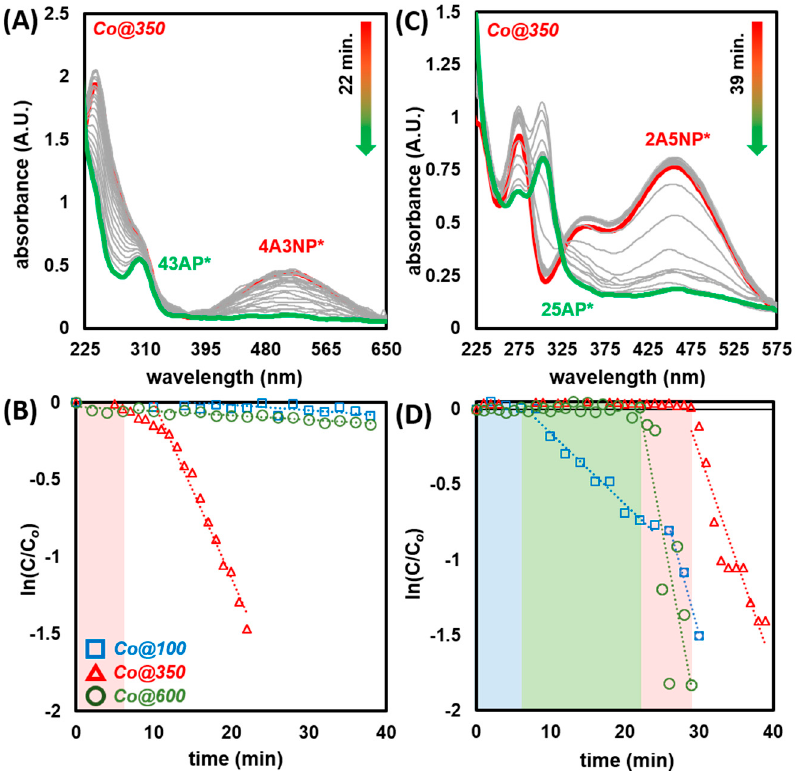
Figure 10. ( A ) UV-Vis spectra of the reduction of 4A3NP by Co@350 (SI for Co@100 and Co@600) and ( B ) plot of ln(C / Co) as a function of time for the reduction of 4A3NP by Co@100, Co@350, and Co@600. ( C ) UV-Vis spectra of the reduction of 2A5NP by Co@350 (SI for Co@100 and Co@600) and ( D ) plot of ln(C / Co) as a function of time for the reduction of 2A5NP by Co@100, Co@350, and Co@600. Note, color blocks represent induction times.